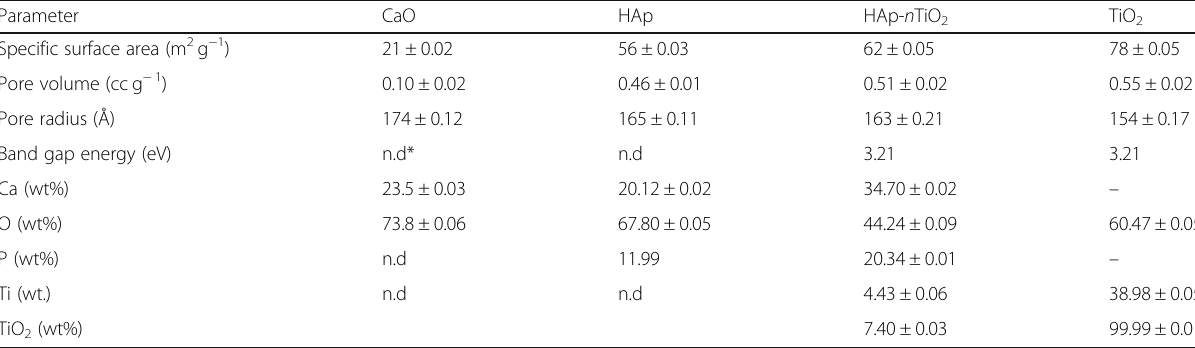
Table 1 Surface parameters and elemental analysis result of materials